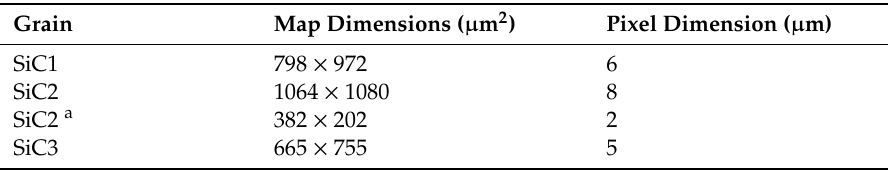
Table 1. Measurement conditions for microdi ff